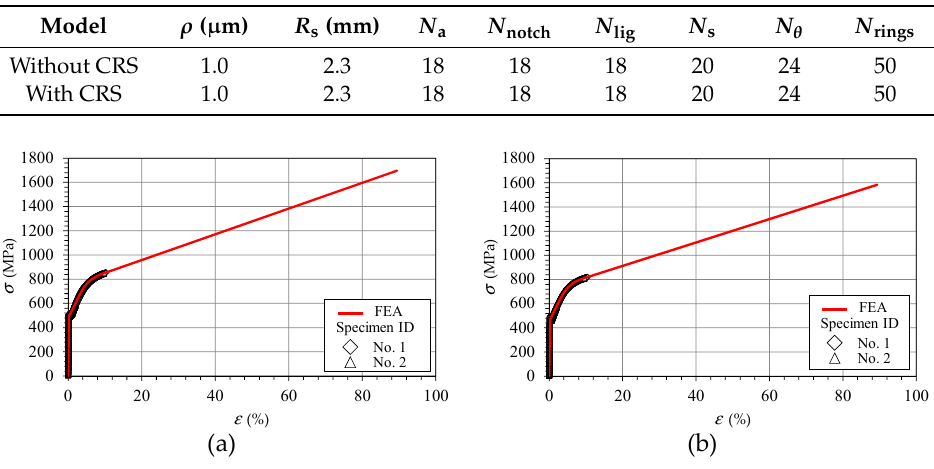
Figure 11. True stress–true strain curves for S45C used in elastic-plastic finite element analysis (EP-FEA) compared with the two tensile test results. ( a ) − 10 °C, ( b ) 20 °C.